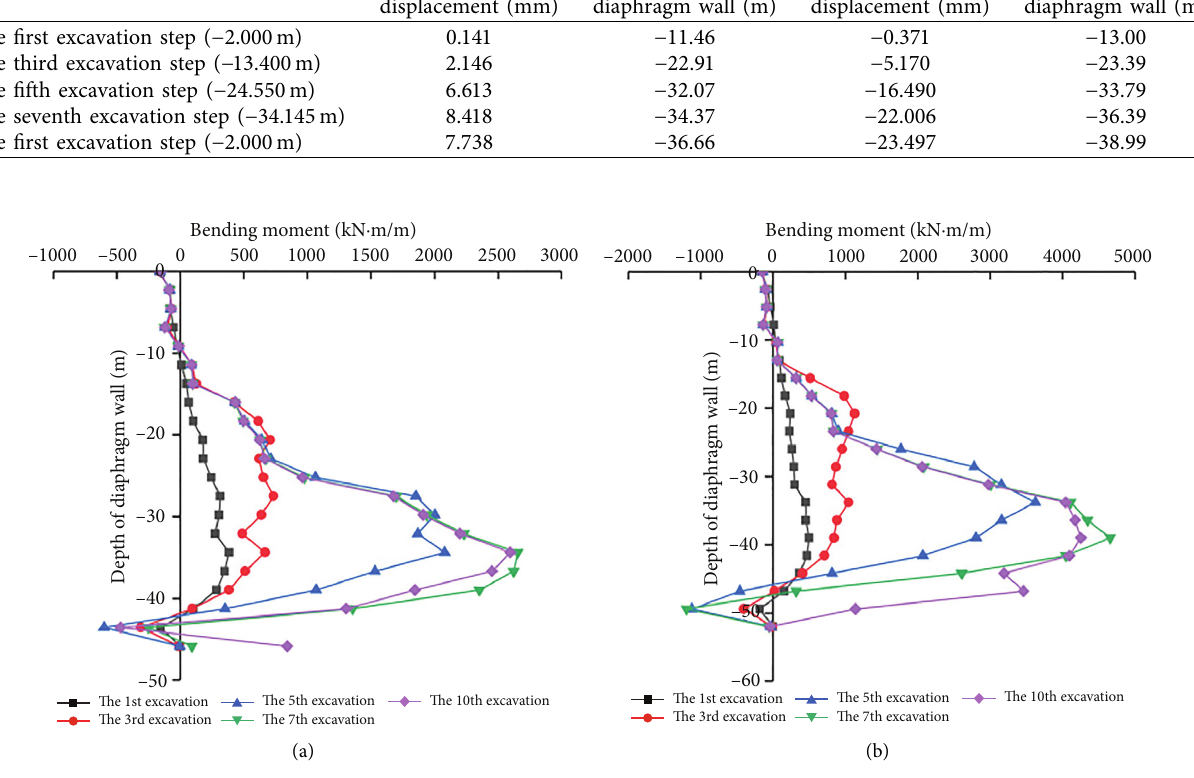
Figure 16: The bending moment curve of the suspended foot diaphragm wall. (a) West wall. (b) East